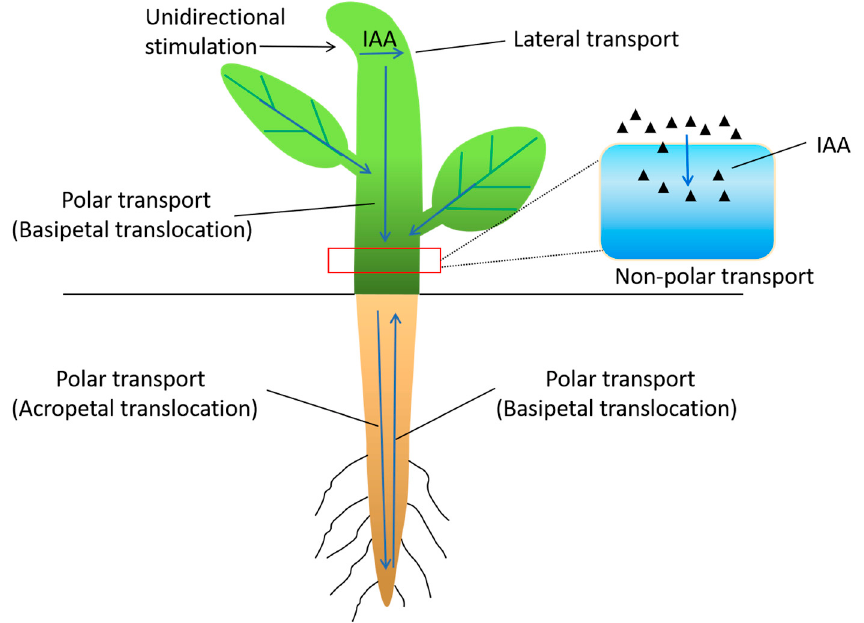
Figure 1. Three modes of auxin transport in plants: non-polar transport, polar transport, and lateral transport. The blue arrows indicate the direction of the auxin flow (refer to Jiang et al., 2011 [21]; Friml et al., 2002 [22]; Rashotte et al., 2000 [24]; Xu et al., 2012 [25]; Zou et al., 2018 [26]).